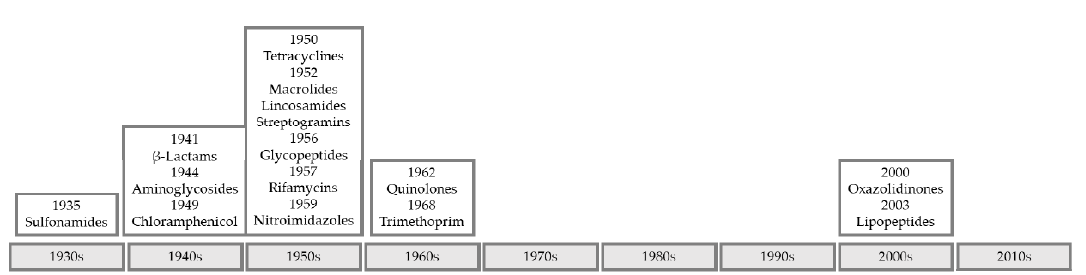
Figure 1. Timeline of the introduction of novel antibiotic classes into clinical practice.